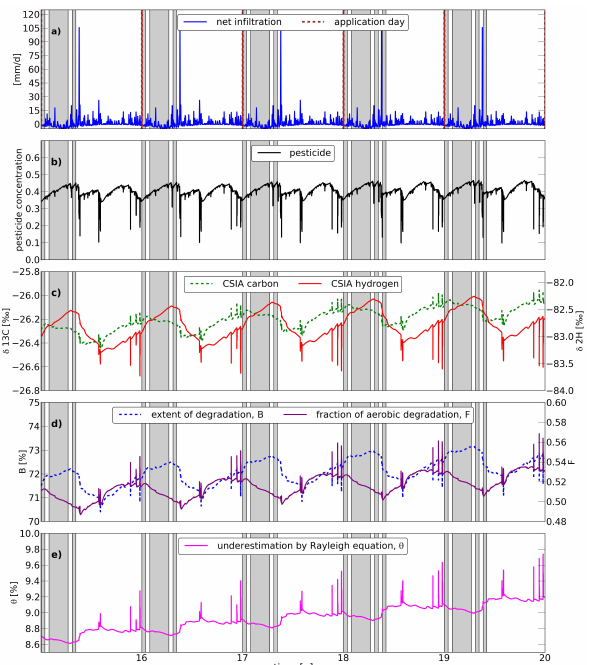
Fig. 6. Results of the last five years of the transient simulation at the hillslope outlet (after 15yr of spin-up): application days and net infiltration (a) ; pesticide concentrations (b) ; δ 13 C and δ 2 H iso- tope ratios (c) ; extent of degradation and relative contribution of the aerobic reaction pathway to overall degradation based on the two- dimensional Rayleigh equation approach (d) ; and underestimation of the extent of degradation resulting from the use of the Rayleigh equation (e) . Periods with a negative net infiltration (dry periods) are shaded in